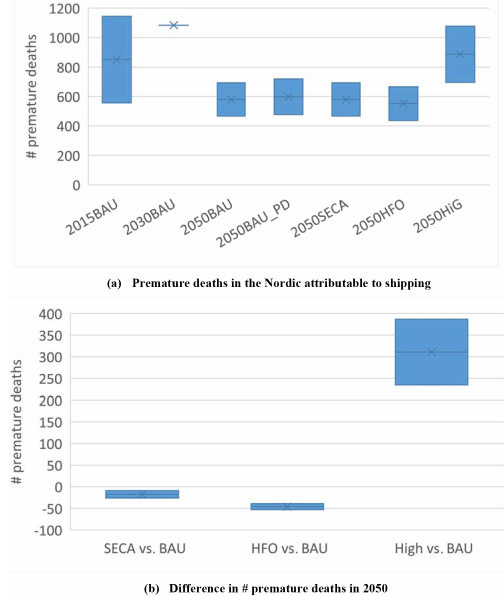
Figure 9. (a) The estimated number of premature deaths attributable to shipping. The difference between 2050BAU and 2050BAU_PD shows the impact from polar diversion routes. Note that the 2030BAU and the SECA, HFO and HiG scenarios also includes the polar diversion routes. (b) Zoom in on the difference between the scenarios and BAU in